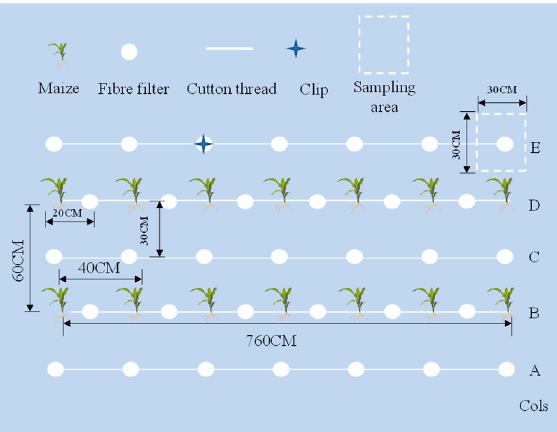
Figure 14. Sampling point layout.